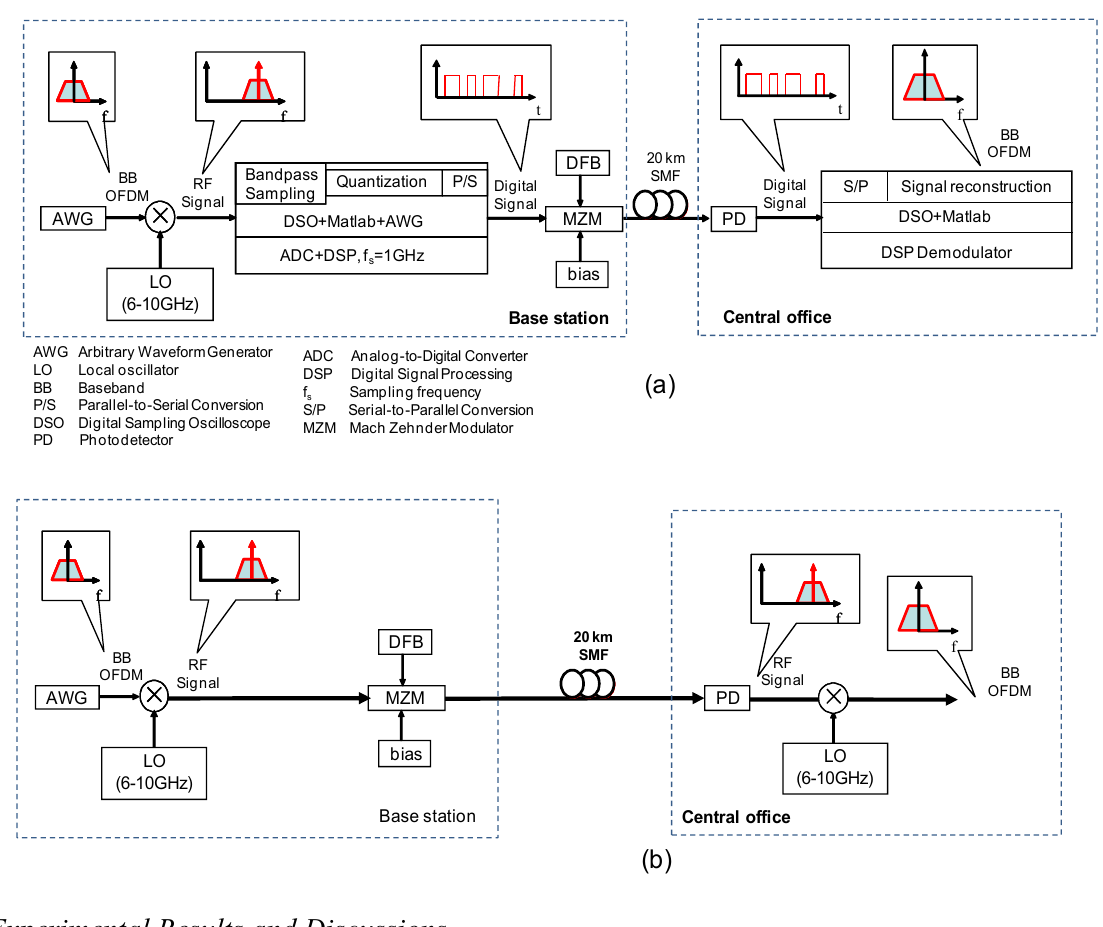
Figure 4. Experimental setup for ( a ) digitized RF-over-fiber transport and ( b ) analog RF-over-fiber transport of wideband OFDM signal. © [2008] IEEE. Reprinted, with permission, from IEEE OSA Lightwave Technology,